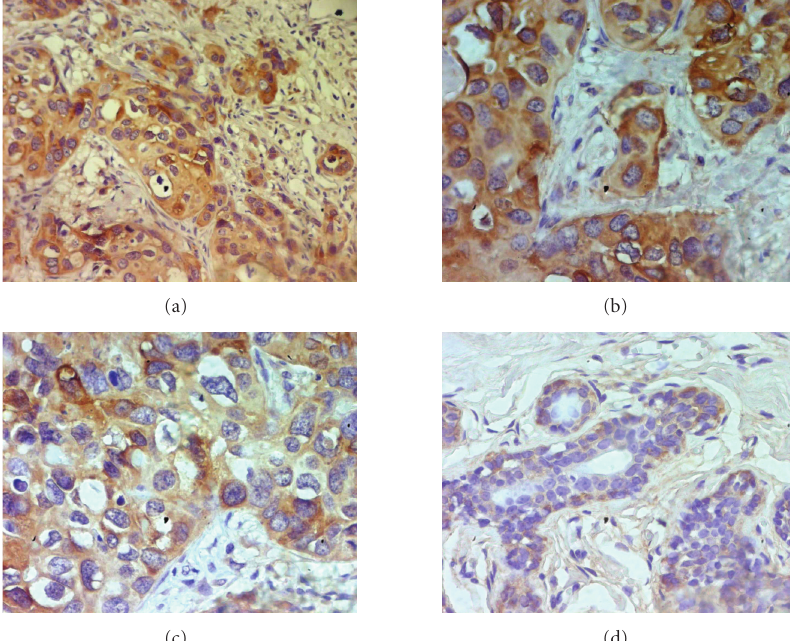
Figure 3: Overexpression of α -B crystallin in infiltrating ductal carcinoma tissues of the breast. Formalin-fixed, para ffi n-embedded sec- tions were immunostained with rabbit polyclonal antibody against α -B crystallin. Tissues were stained with hematoxylin and viewed by light microscopy. A strong staining (brown) in tumor cells (T) has been observed, whereas α -B crystallin was expressed at lower levels in normal epithelial cells. (a) α -B crystallin expression in IDCA tissues (200x magnification), (b)-(c) α -B crystallin expression in IDCA (400x magnification), (d) α -B crystallin expression in nontumor tissues (400x